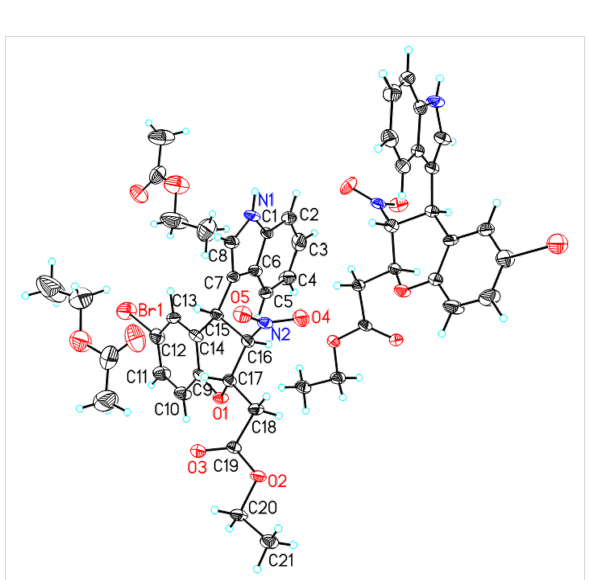
Figure 2: X-ray crystal structure of the major diastereomer of 3g (one symmetric molecule and two solvent molecules are not labeled for